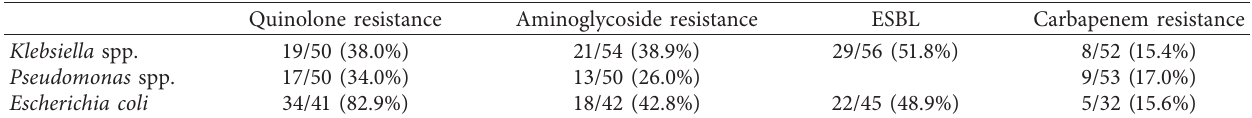
Table 3: Antibiotic resistance pattern of gram-negative isolates.